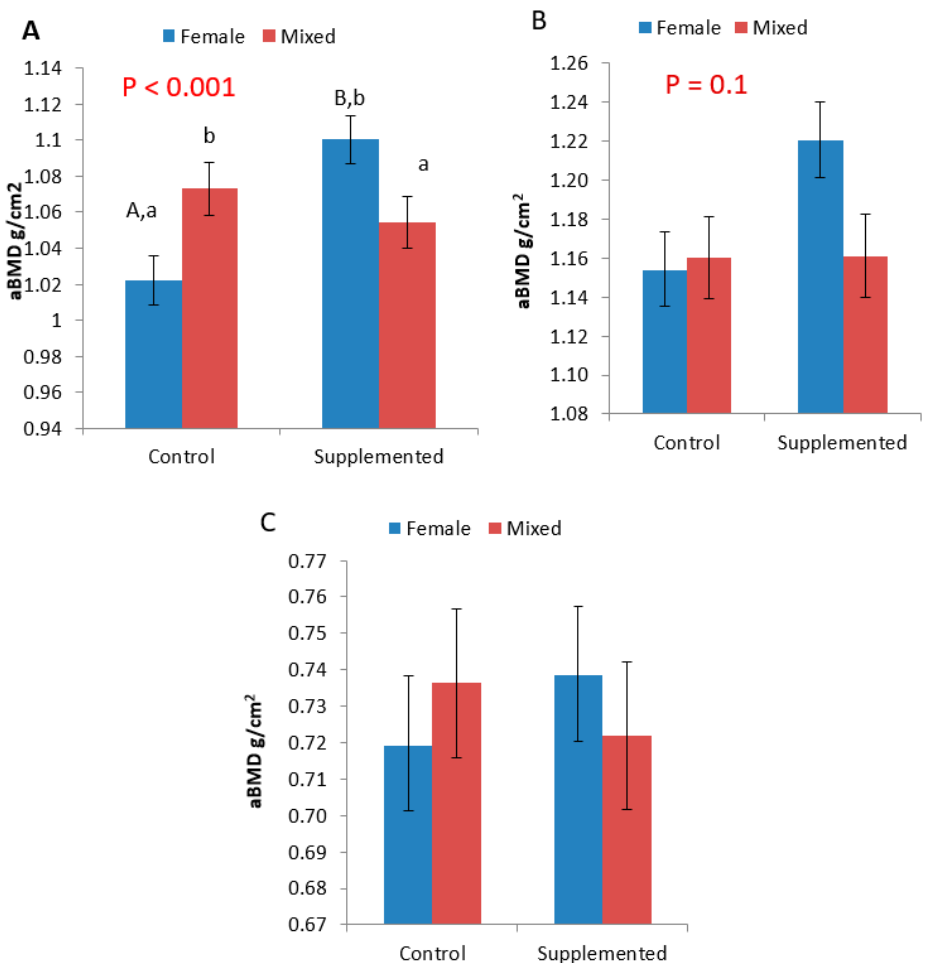
/ Ulna and ( C ) Metacarpal. The P values Figure 2. aBMD values for the A ) Humerus, B ) Radius/Ulna and C ) Metacarpal. The P values represent Figure 2. aBMD values for the ( A ) Humerus, ( B ) Radius represent the interactive e ff ect between group composition and diet. The lower-case letters (a,b) indicate a tendency for a di ff erence of P < 0.1 between group composition and within dietary treatment, whereas upper-case (A,B) superscripts indicate a di ff erence of P < 0.001 between dietary treatment and within group